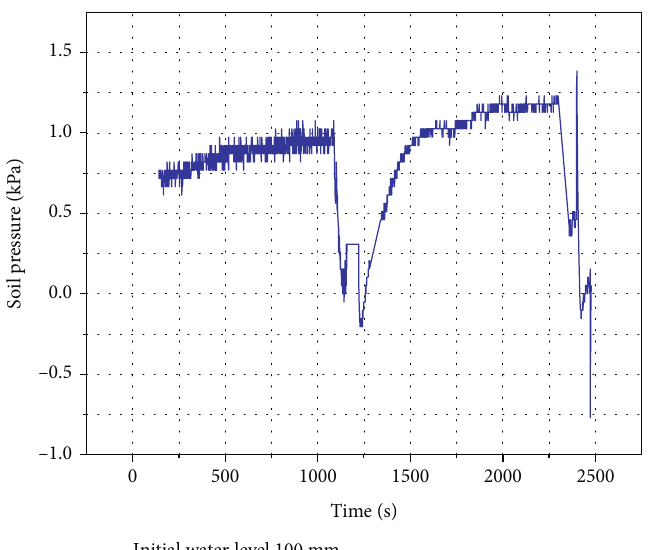
Figure 7: Variation of soil pressure with time.